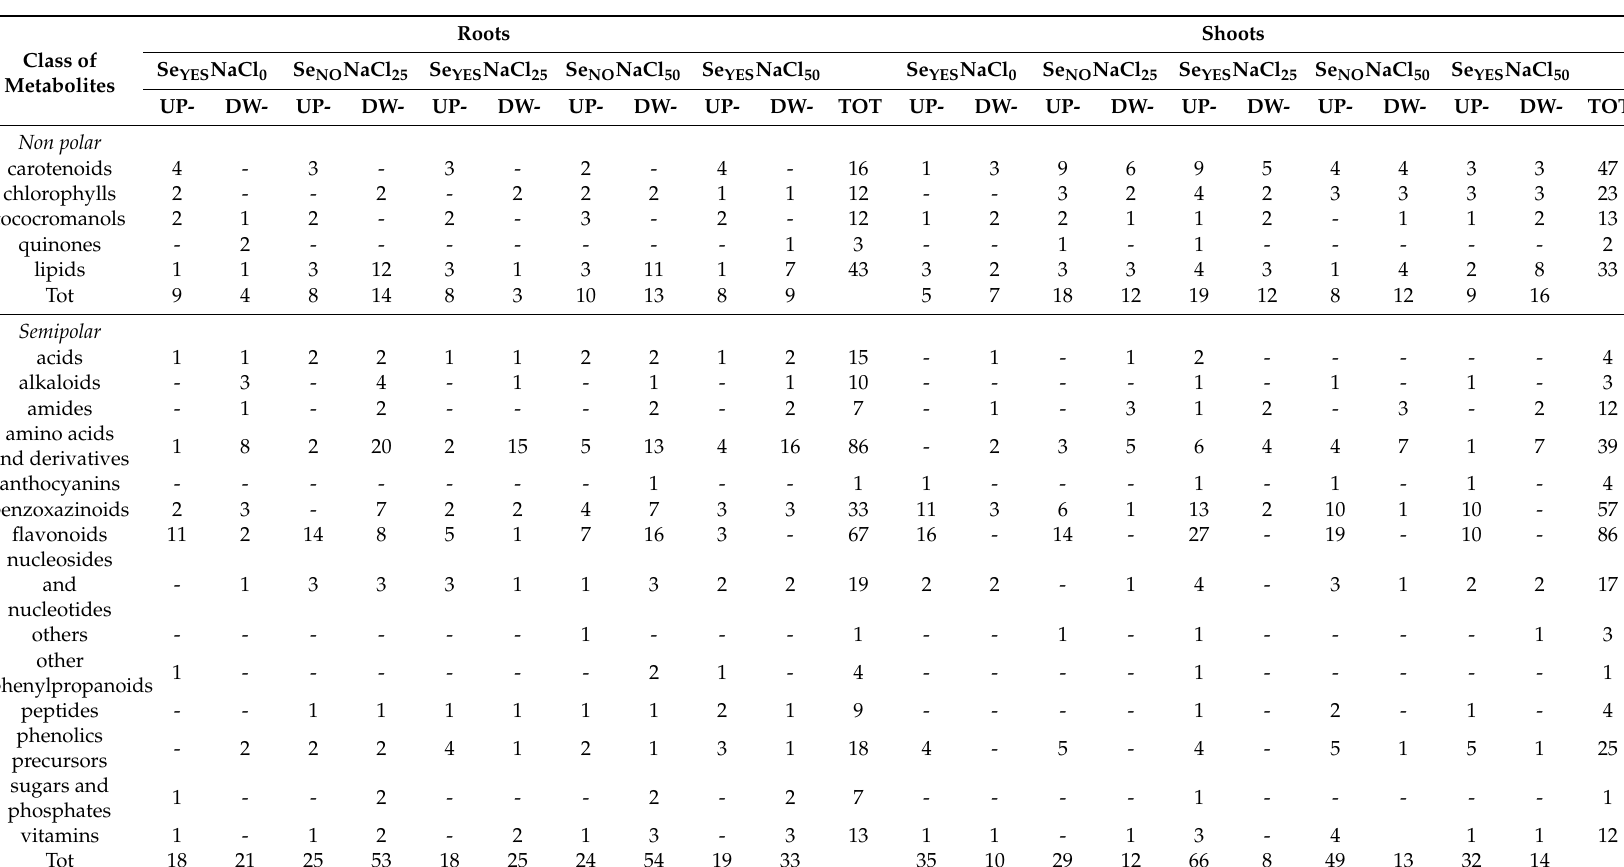
Table 4. Number of di ff erentially accumulated metabolites in non-polar and semipolar metabolomes of maize sprouts obtained at 0, 25, or 50 mM NaCl (i.e., NaCl 0, NaCl 25, and NaCl 50 , respectively) from grains produced without or with Se fertilization (i.e., Se NO and Se YES , respectively) in comparison to the control Se NO NaCl 0 . Class of